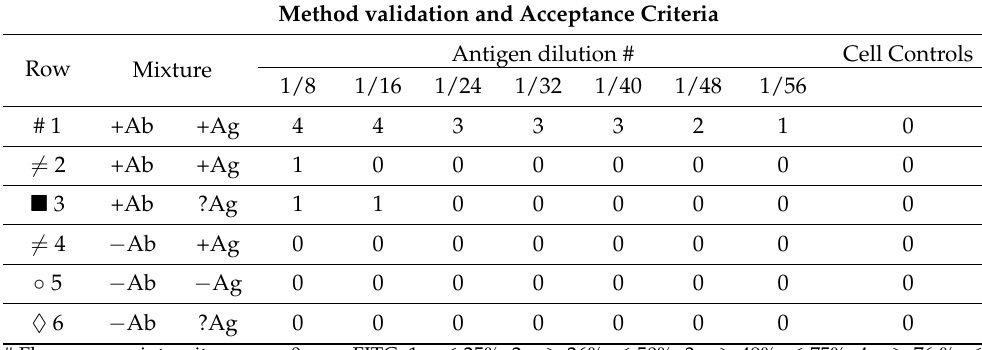
Table 1. Assay validation. Levels of type-specific anti-coronavirus antibodies detected in the human sera of COVID-19-positive or -negative patients. Method validation and Acceptance